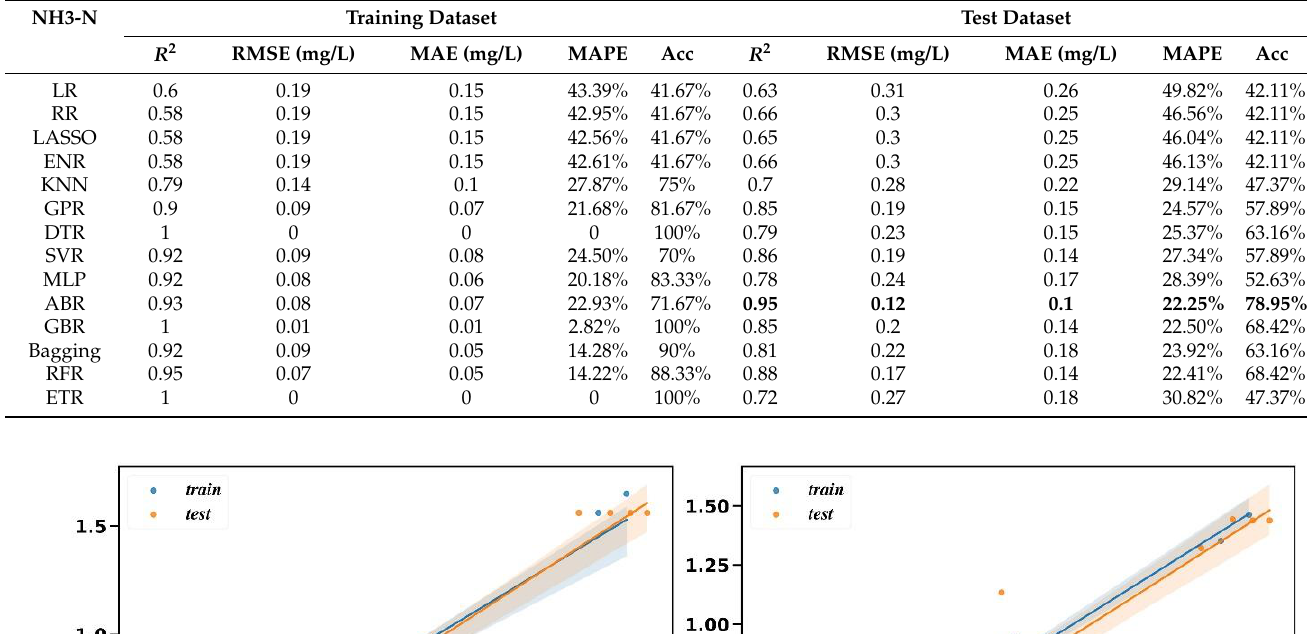
Table 7. Performance of fourteen models on NH3-N training dataset and test dataset.